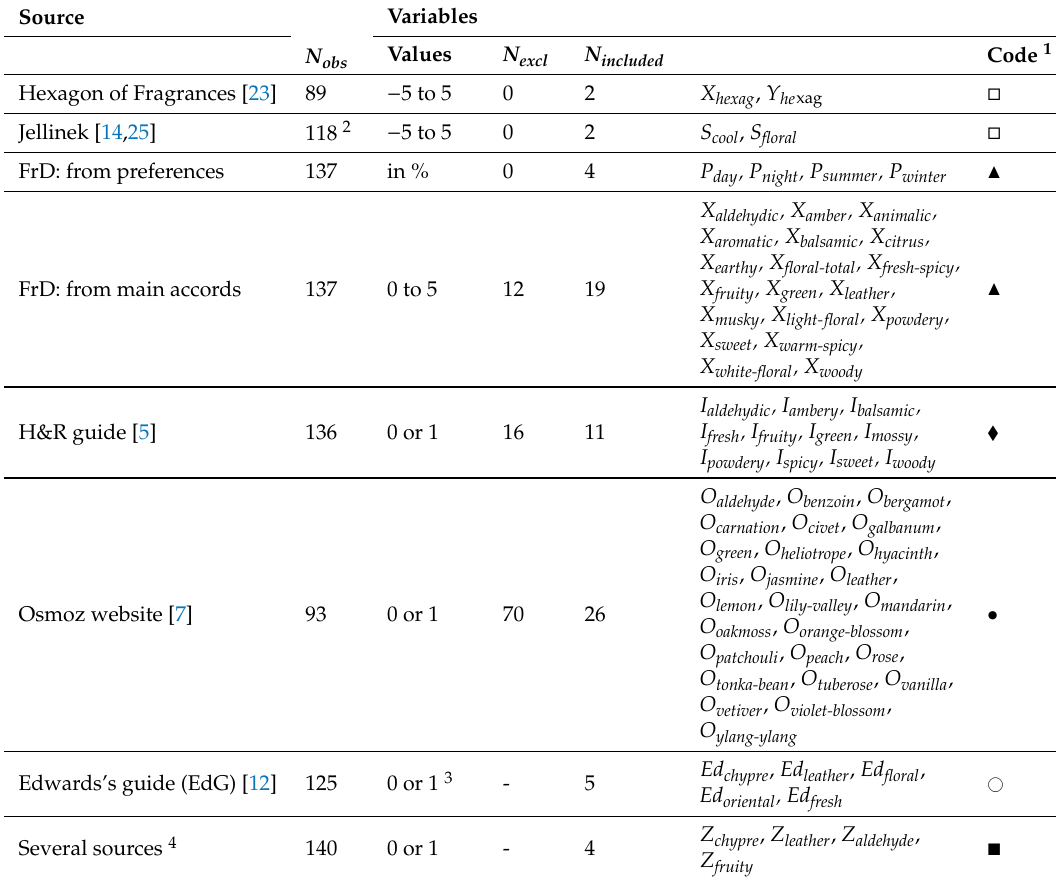
Table 1. Variables compiled from Fragrantica [8] (FrD) and di ff erent catalogs for a set of 140 fragrances: number of observations retrieved from the source ( N obs ), number of variables excluded ( N excl ), and list of variables included in the multivariate analysis (73 in